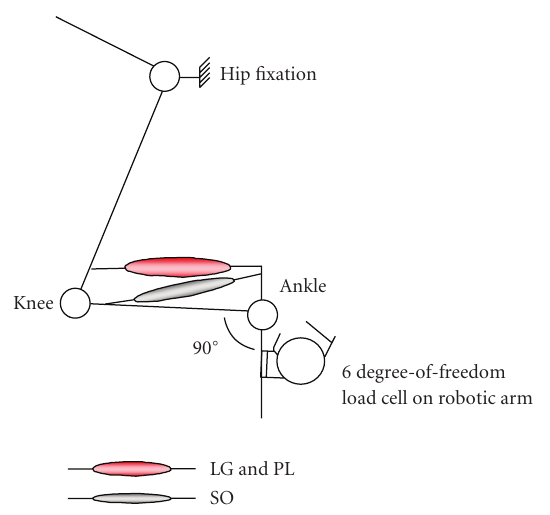
Figure 3: A schematic presentation of the cat hindlimb in the experimental setup used to investigate inter-synergist interactions